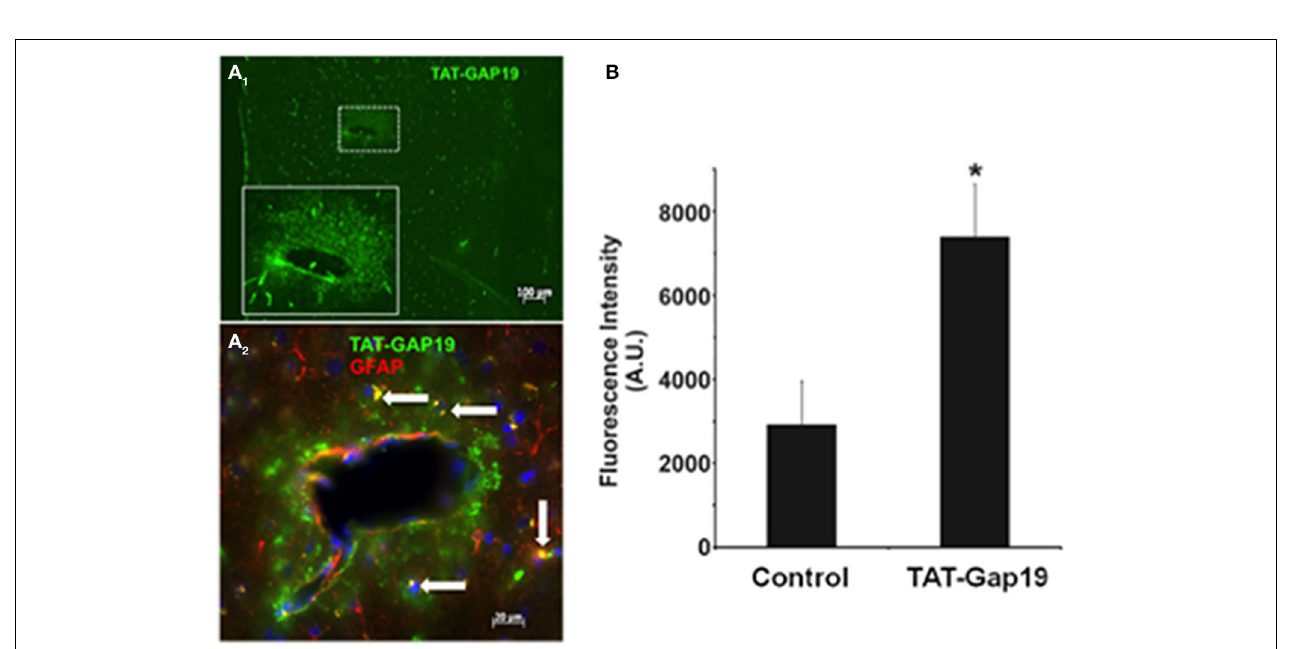
with (lower row) 344 μ M Gap19 treatment. Scale bar: 10 μ m. (B) Summary graph demonstrating significant Etd + uptake in astrocytes that was inhibited by Gap19 used at concentration of 344 and 688 μ M. Statistical comparisons in (B) were done with the stimulus condition without Gap19 ( n = 3 independent experiments; ∗∗∗ p < 0 . 001).